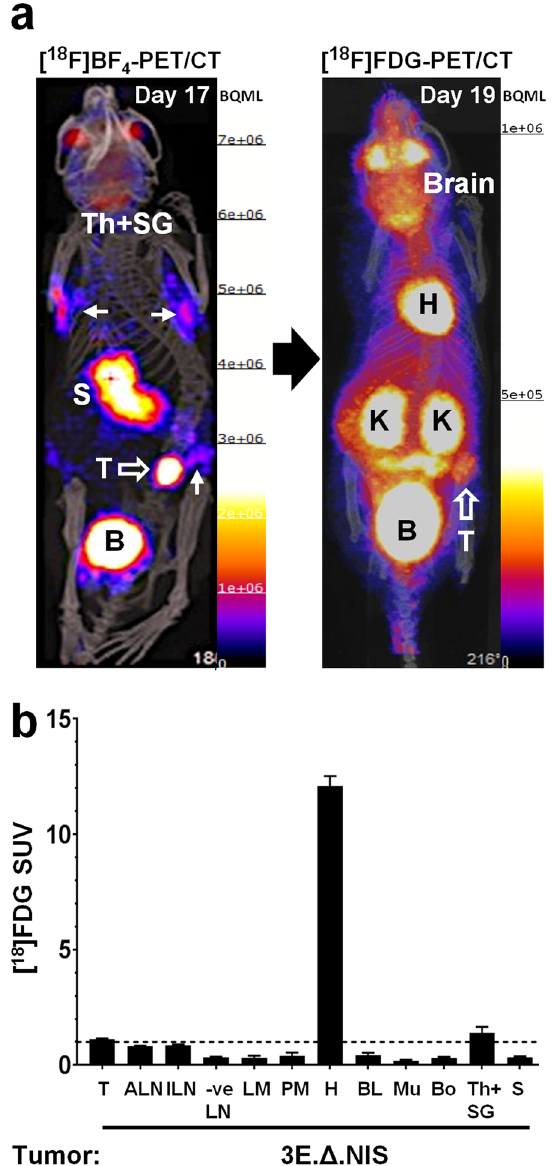
Figure 6. Metastasis detection with [ 18 F]BF 4 − -PET is superior to metabolic imaging by [ 18 F]FDG-PET in the NIS-expressing tumor model. 3E. Δ -NIS tumors were established and grown to sizes of ~350 mm 3 before being imaged (see Materials and Methods). ( a , left) Animals were first imaged by [ 18 F]BF 4 − -PET. A maximum intensity projection (overlaid on CT) is shown. Abbreviations are: bladder (B), stomach (S), thyroid and salivary glands (Th + SG), and primary tumor (T); open arrow). Full arrows point to metastatic sites, which include the following objects in this animal (from left to right and top to bottom): right axillary LN, left axillary LN, left inguinal LN (draining LN of the primary tumor). ( a , right) The animals were allowed to recover after imaging and the radioactivity was allowed to decay (48 h) before metabolic imaging with [ 18 F]FDG-PET was performed on the same animals. A maximum intensity projection (overlaid on CT) of the same animal as in ( a ) is shown. Abbreviations are: bladder (B), heart (H), kidneys (K), and primary tumor (T; open arrow). Signal-to- background is insufficient to identify any of the metastatic sites previously identified in ( a , left). ( b ) [ 18 F]FDG biodistribution data expressed as SUV as determined by γ -counting post tissue harvesting. Abbreviations are (from left to right): primary tumors (T), axillary lymph nodes (cancer positive; ALN), inguinal lymph nodes (cancer cell positive; ILN), metastasis-free lymph nodes (-veLN), liver metastases (LM), peritoneal metastases (PM), heart (H), blood (BL), muscle (Mu), bone (whole femur; Bo), thyroid and salivary glands combined (Th + SG), and stomach (S). Shown are pooled data (N = 8 animals) and error bars represent SEM. While lymph node metastasis could not be identified by imaging ( a , right), ex vivo γ -counting allowed the differentiation of LNs that contained cancer cells (ALN, ILN) from metastasis-free LNs (-veLN), albeit with a small dynamic range. Liver (LM) and peritoneal (PM) metastases were not distinguishable from metastasis-free organs by ex vivo γ